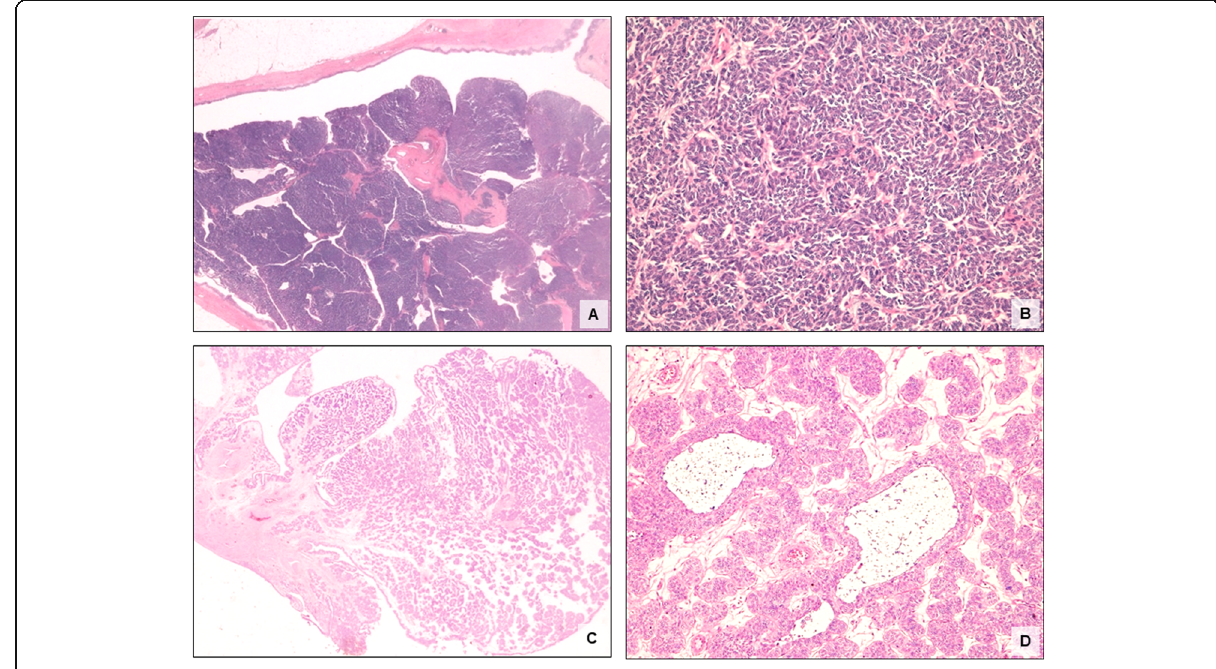
Fig. 1 Histological features of two cases of IUP of the upper urinary tract. Sessile polypoid tumour of the renal pelvis consisting of anastomosing trabeculae and cords growing downward into the lamina propria, with prominent peripheral palisading in the trabeculae ( Case 1: a, b). Pedunculated polypoid IUP of the distal ureter characterized by microcyst formation and foci of squamous metaplasia ( Case 2: c,